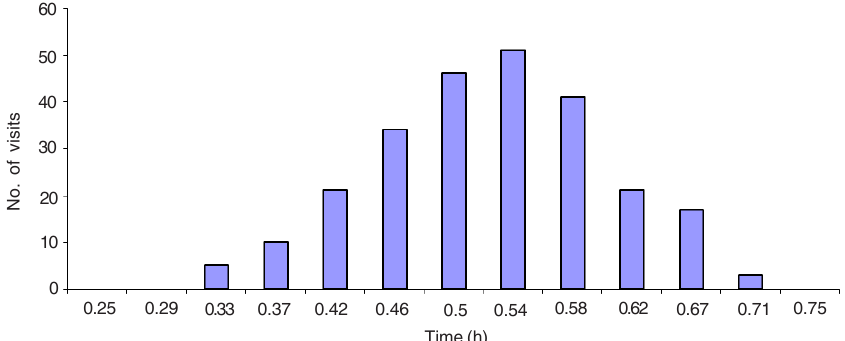
Figure 1. Foraging activity of Bombardier Beetle Brachinus sp. on Decalepis